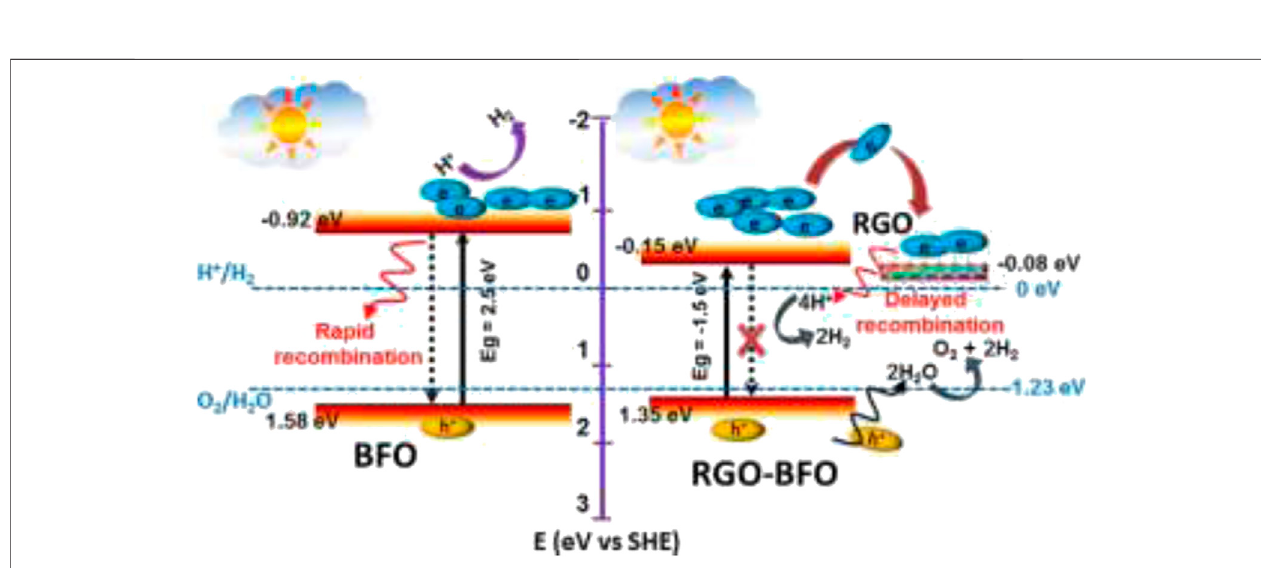
FIGURE8| Schematicrepresentation ofthe proposed mechanism ofphotocatalysis ofBFO and RGO – BFOreproducedwithpermission (Mukherjee etal.(2018)).